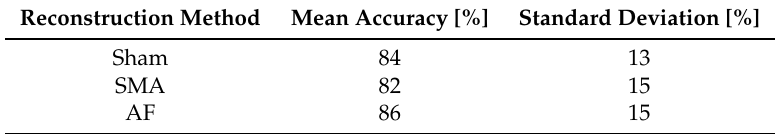
Figure 10. Average ERP at PO8 after application of the detection algorithm for sham and stimulation, at 40 Hz 250 µ A stimulation in a single subject. All peaks are detected at the expected times and the expected increases in N170 and N400 depths are seen when face stimuli are presented. Note that the sham and stimulation are different protocols and thus the EEG trace for sham and the other figures are not expected to be identical. Table 3. Mean detection scores and standard deviation which represent the percentage of successful trials where an ERP was detected for both face and non-face stimuli. The scores are aggregated for all subjects and all different protocols ( n = 30 for all stimulation conditions and